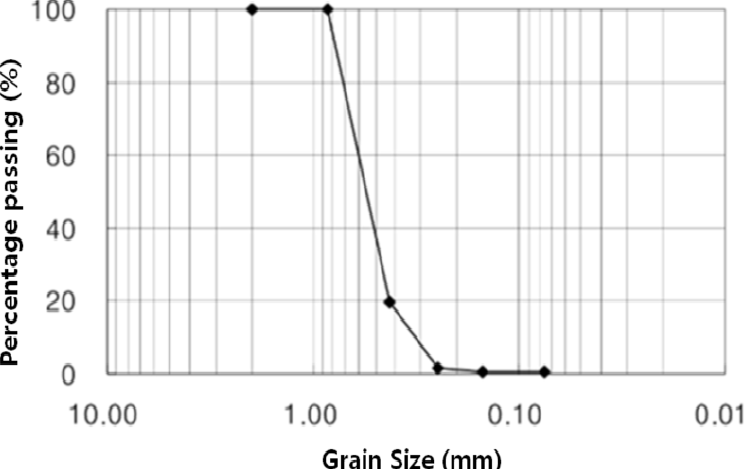
Figure 2. Particle distribution of Jumunjin standard sand. Table 1. Properties of Jumunjin standard